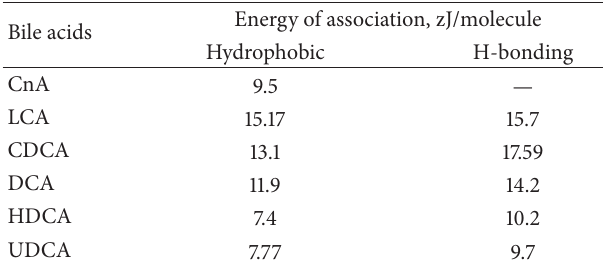
Table 2: Molecular energy values calculated as ( 𝜋 ⋅ 𝐴 ) at character- istic points of the 𝜋 - 𝐴 isotherms as discussed in the